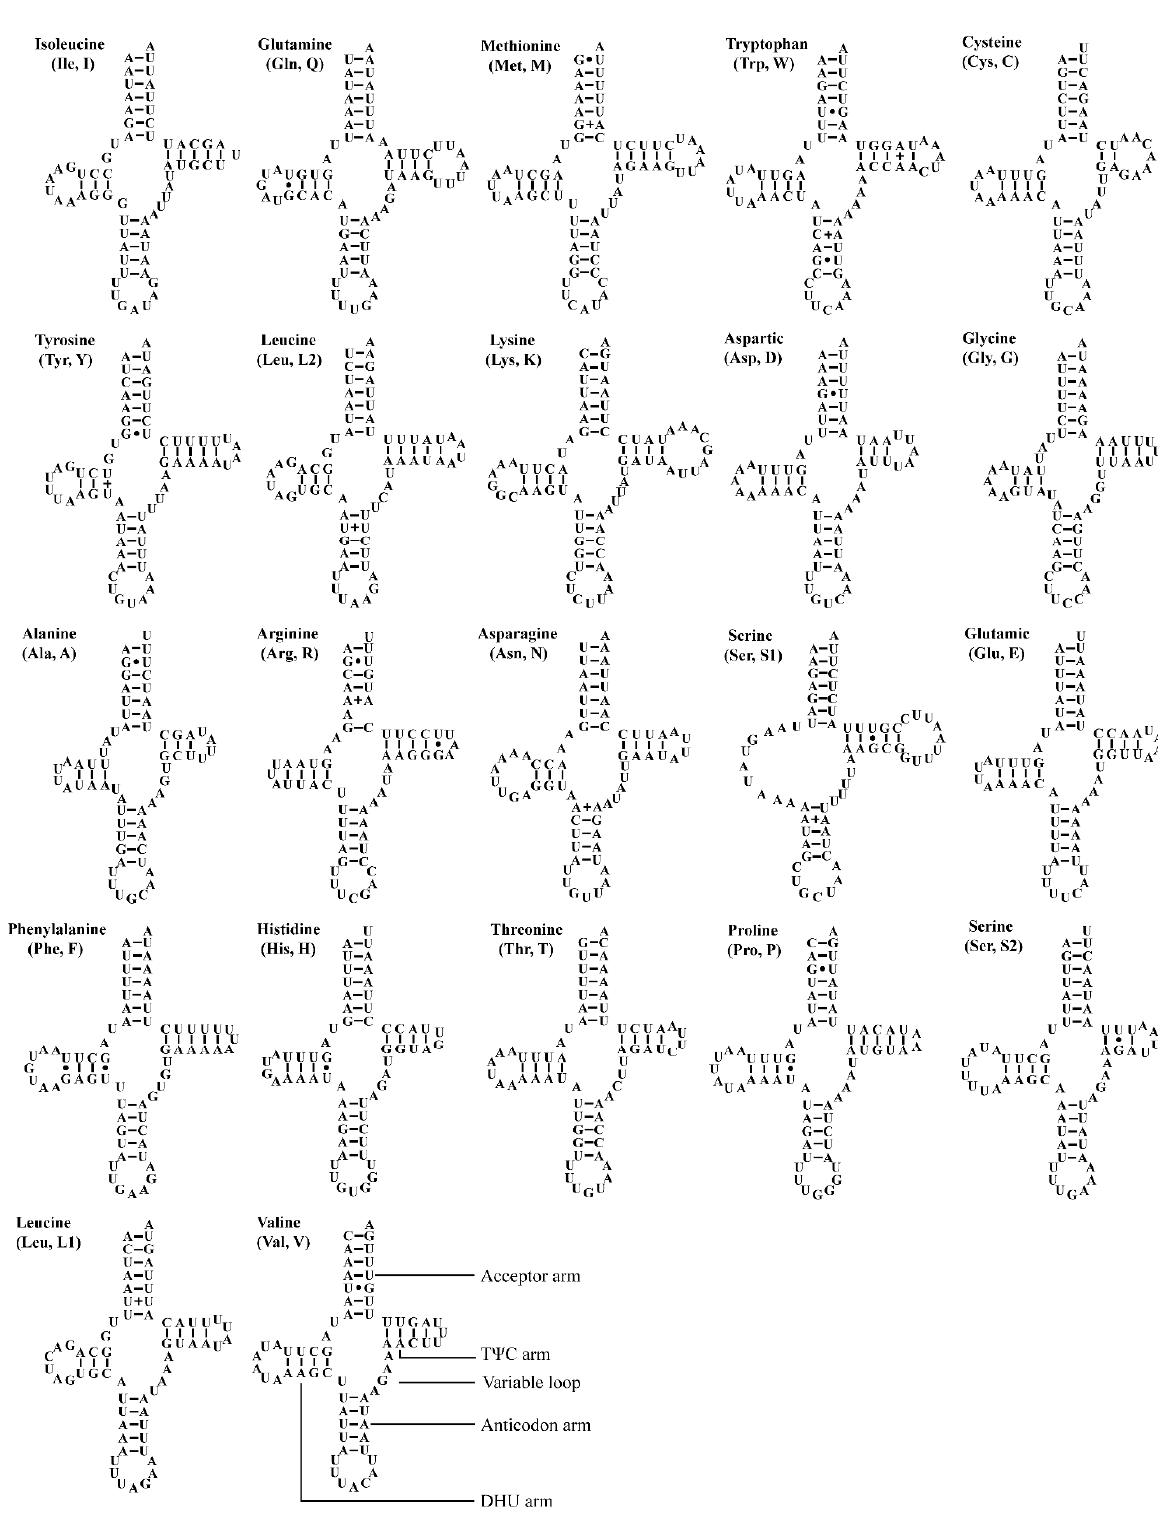
Figure 4. Predicted secondary cloverleaf structure for the tRNAs of Atkinsoniella grahami . The tRNA arms are illustrated as for trnV. Dashes (–), solid dots ( • ), and pluses (+) indicate the Watson–Crick base pairings, G–U bonds, and mismatches, respectively.